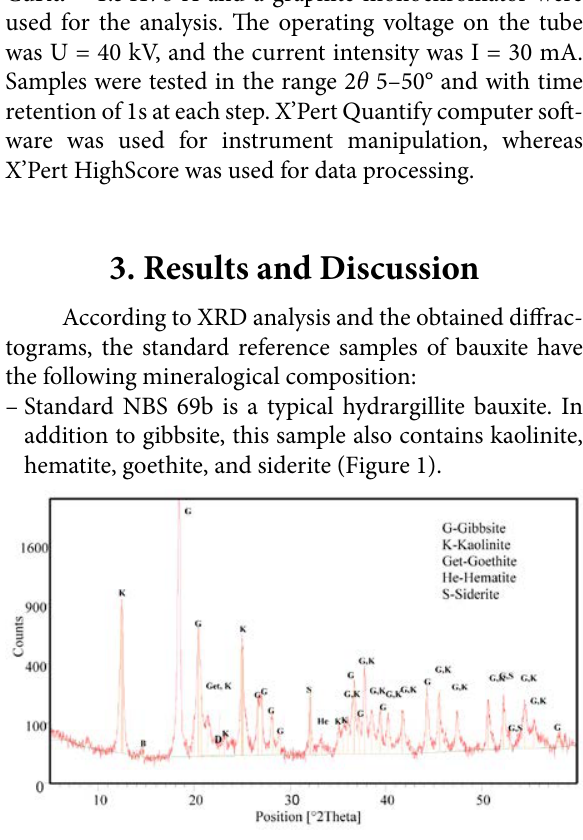
Figure 1. Diffractogram of the standard bauxite sample NBS 69b (Arkansas)